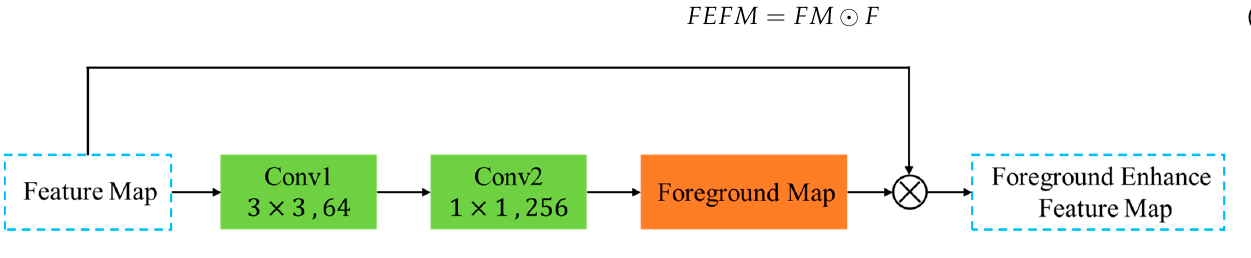
Figure 7. Pipeline of FEM.